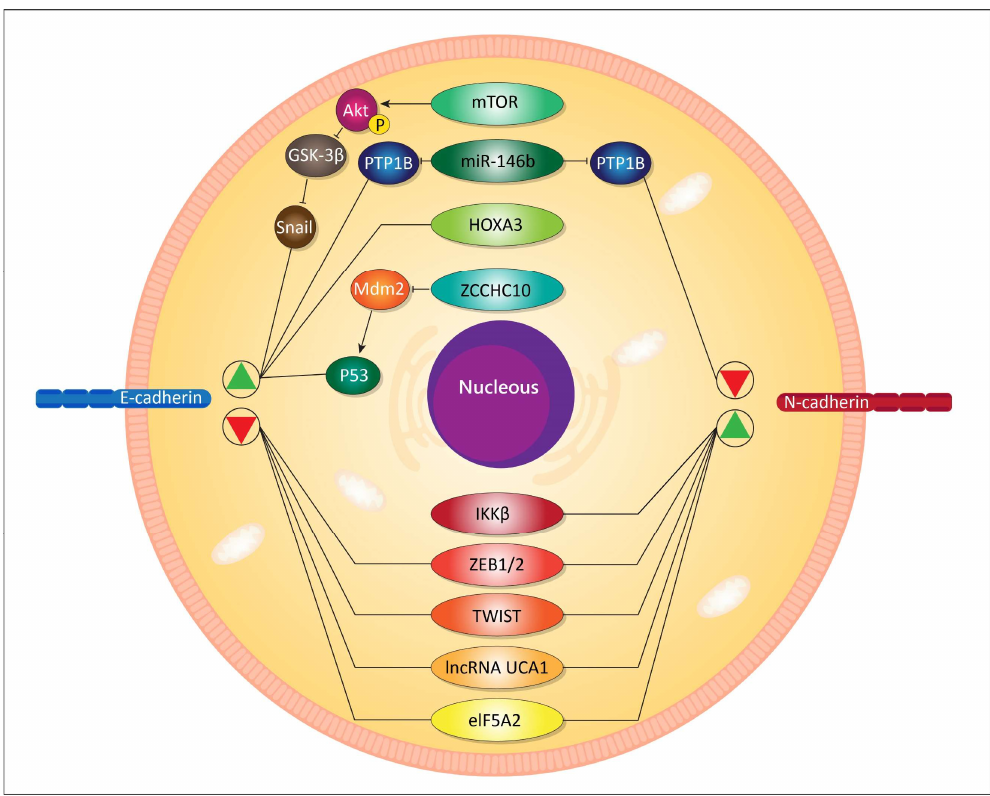
Figure 2. A summary of selected molecular pathways regulating epithelial–mesenchymal transition (EMT) and their possible involvement in resistance to CP therapy. mTOR, mammalian target of rapamycin; Akt, protein kinase B; GSK-3 β , glycogensynthase kinase-3 β ; miR, microRNA; PTP1B, protein tyrosine phosphatase 1B; HOXA3, homeobox A3; Mdm2, mouse double minute 2 homolog; IKK β , Inhibitor of NF- κ B kinase subunit β ; ZEB, zinc-finger E-box binding homeobox; lncRNA, long non-coding RNA; UCA1, urogenital carcinoma antigen 1; elF5A2, eukaryotic initiation factor